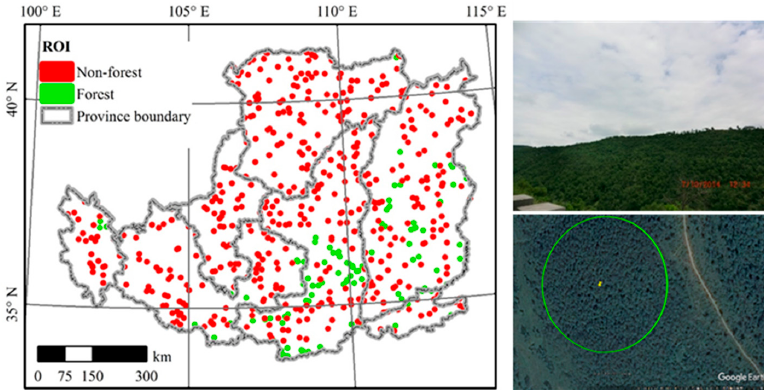
Figure 2. Ground truth samples derived from Google Earth and ground field photos. The procedures of the generation of regions of interest (ROIs) are described in detail in Section